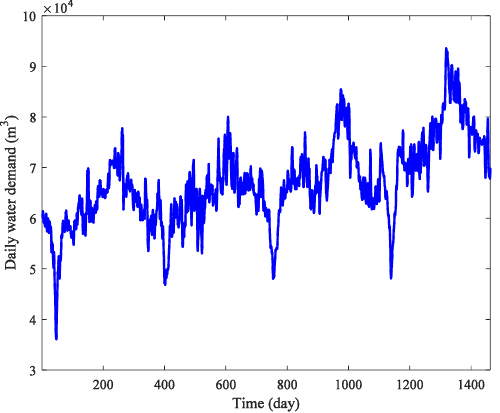
Figure 3. Original daily urban water demand time series for 1 January 2012–1 January 2016.